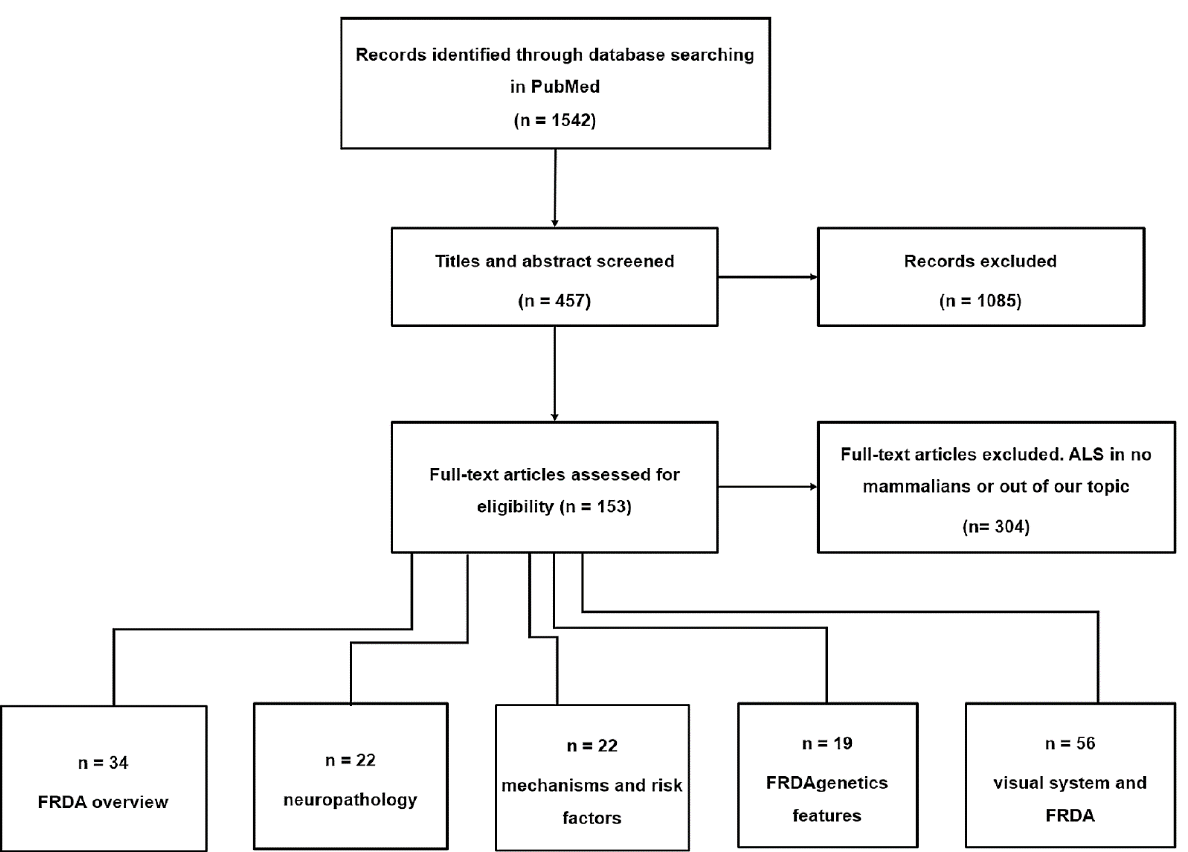
Figure 3. Flow chart materials and methods. Abbreviations: ALS: Amyotrophic lateral sclerosis; FRDA: Friedreich’s ataxia